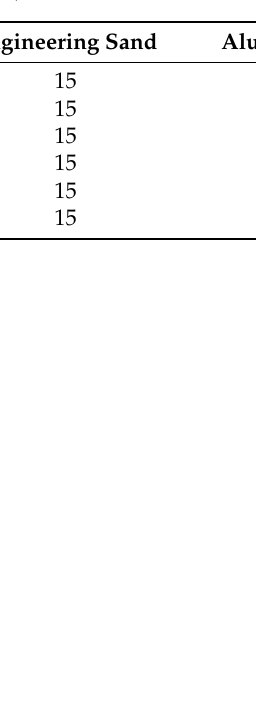
Table 3. Slaked lime and aluminum ash mix design. (wt.%).